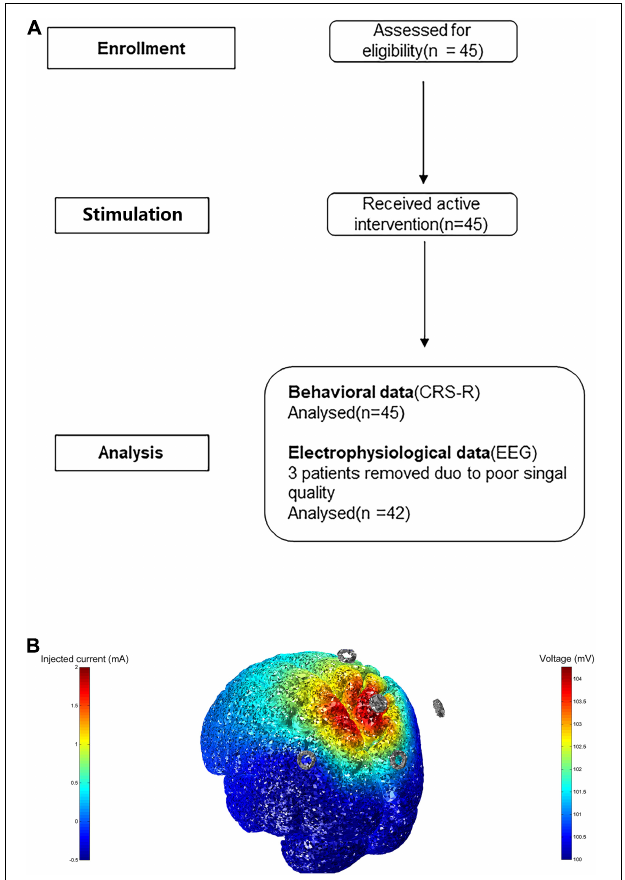
FIGURE 1 | (A) Flowchart of study screening. (B) The model of transcranial electric stimulation. Here we inject 2 mA at electrode Pz, and cathode is at CPz, POz, P3, P4, displaying 3D rendering of the computed voltage and electric field